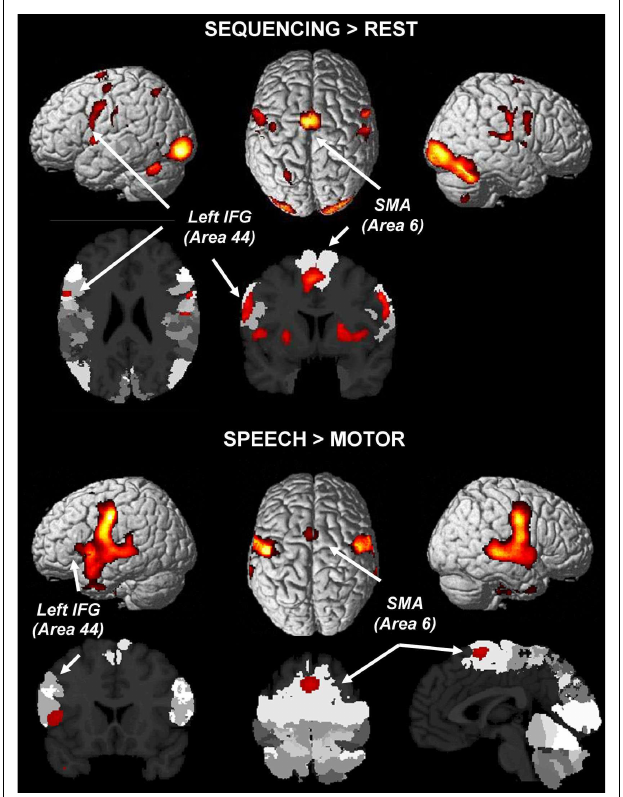
FIGURE 2 |Top: a conjunction analysis of sequencing in all three effector systems (left hand, right hand, speech) without contrasting activation against repetition (as in Figure 2) reveals largely shared networks involving left area 44 in Broca’s region (conjunction analysis of individual maps FWE-corrected at p < 0.05 ). Bottom: comparing speech (single, repeated, or sequenced syllables) to button presses reveals the stronger involvement of area 44 in Broca’s region, bilateral premotor cortex, and the SMA (area 6) (FWE-corrected at p < 0.05